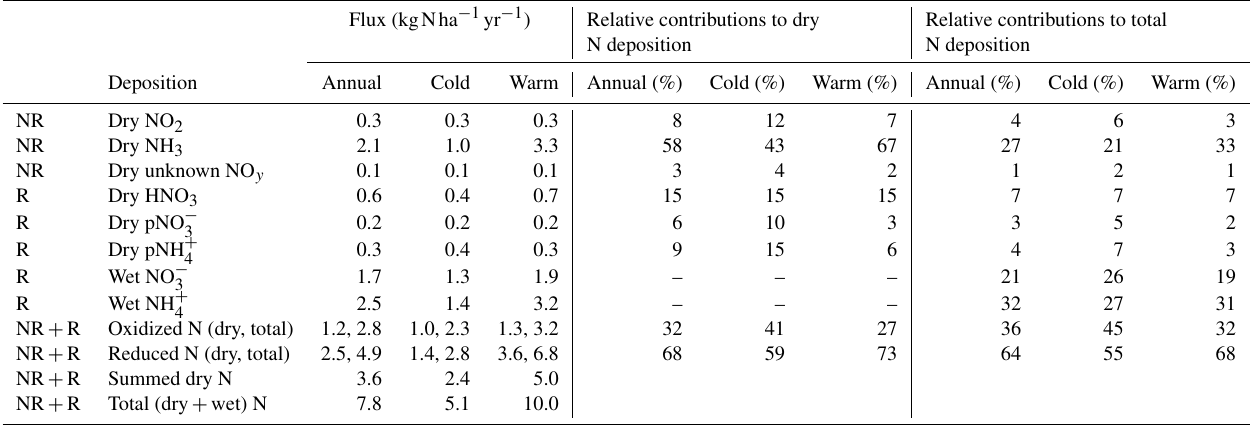
Table 3. Breakdown of atmospheric deposition of non-routinely (NR) and routinely (R) monitored N species at the EGB site in 2010, on an annual basis and during cold (January–April, November–December) and warm (May–October)